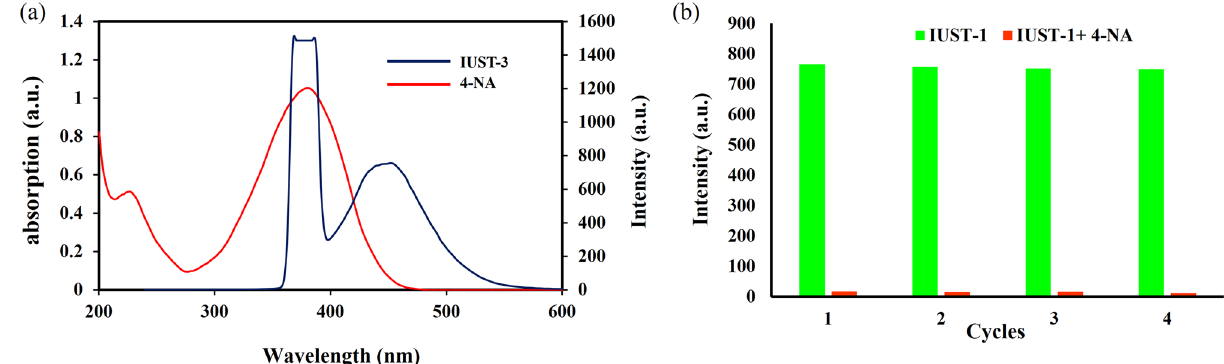
Figure 4. ( a ) Spectral overlap of absorbance spectrum of 4-NA with excitation and emission spectra of the IUST-3, ( b ) Luminescent intensity of the IUST-3 at 380 nm after four cycles for